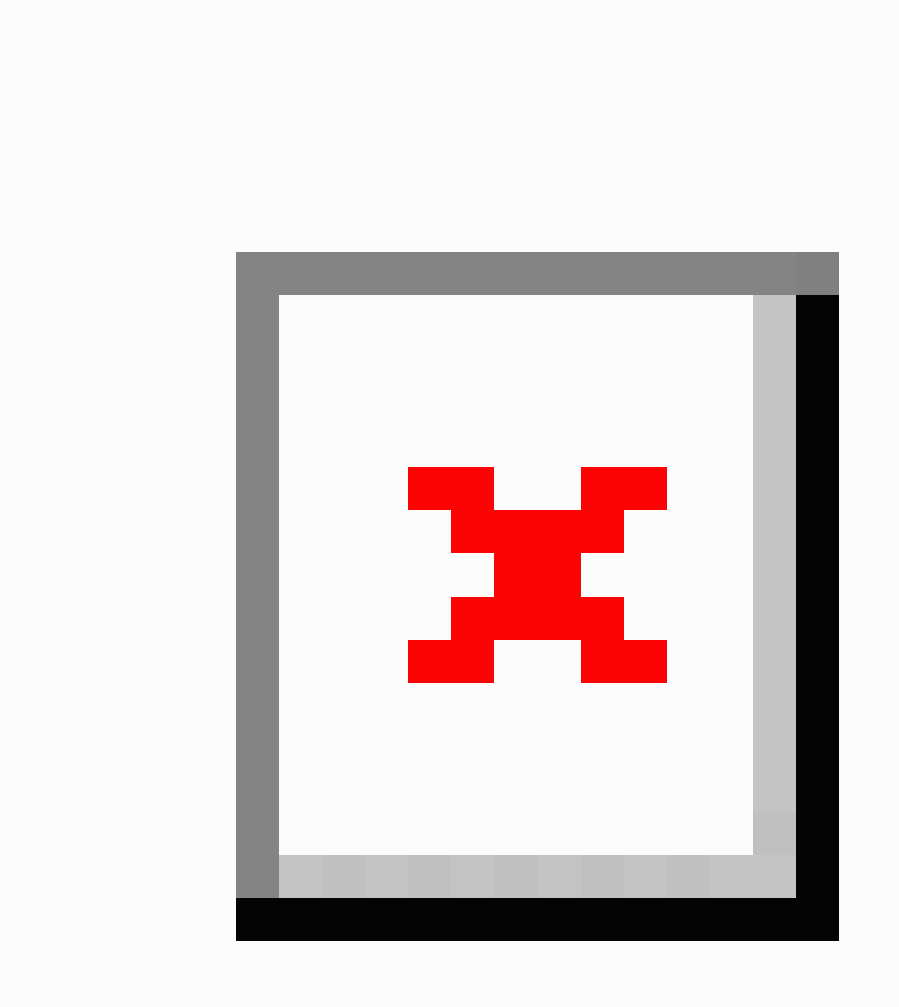
Figure 3. Knowledge base accuracy by